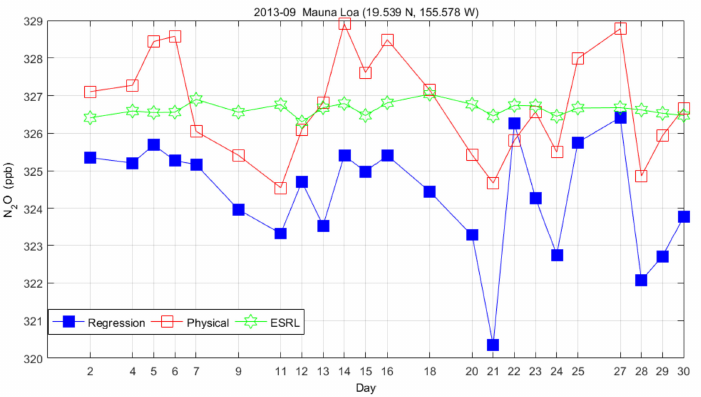
Figure 16. Comparison of the results retrieved from the AIRS data and the MLO observations for September